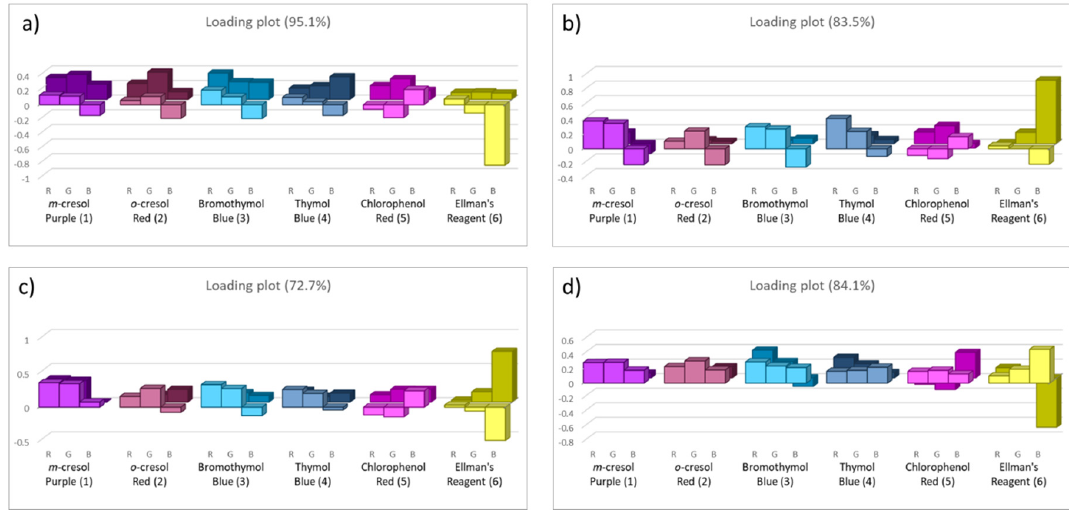
Figure 4. The loading plots of the PCA models on the first two principal components, considering all the samples of chicken meat ( a ), beef meat ( b ), pork meat ( c ) and cod fillets ( d ) kept at room temperature.